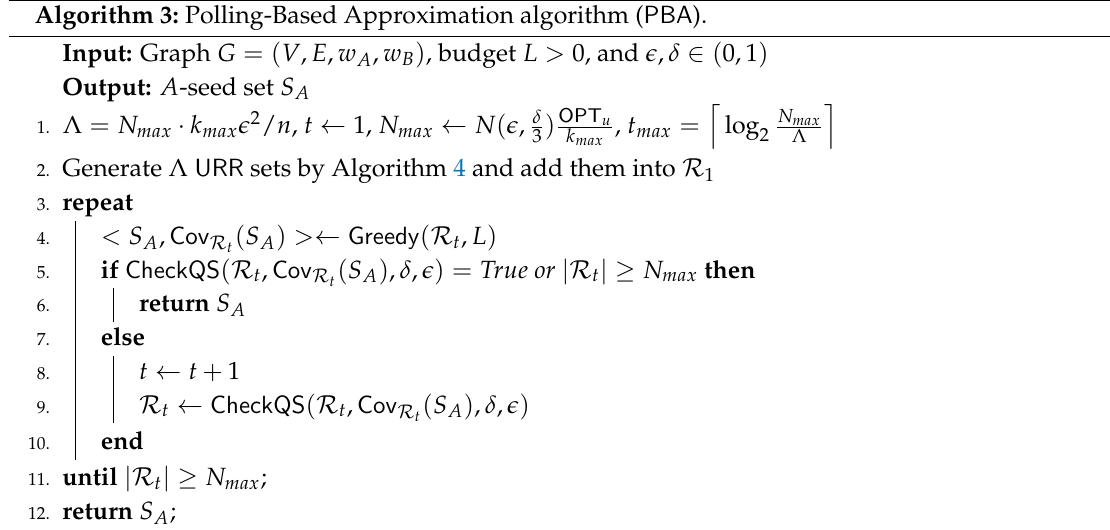
Algorithm 3: Polling-Based Approximation algorithm ( PBA